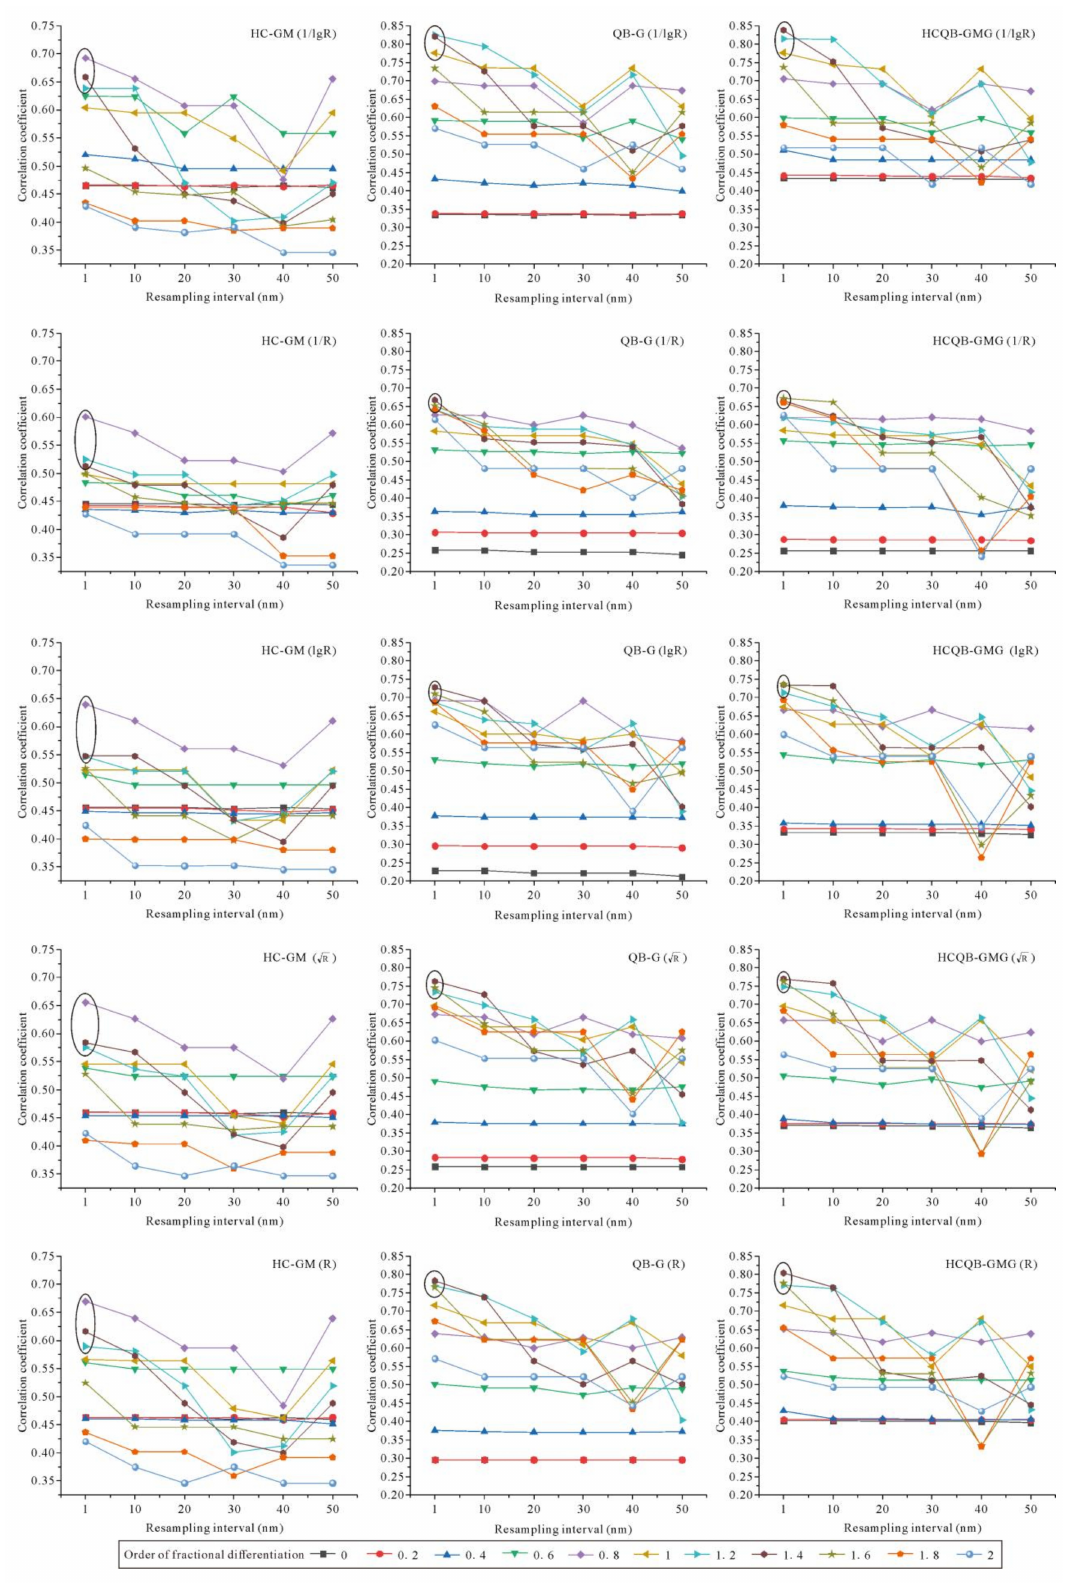
Figure 5. The absolute value of the correlation coefficient between EC and hyperspectral reflectance with different resampling intervals and orders, and the circles denote the fractional order correspond- ing to the top three absolute values of the correlation